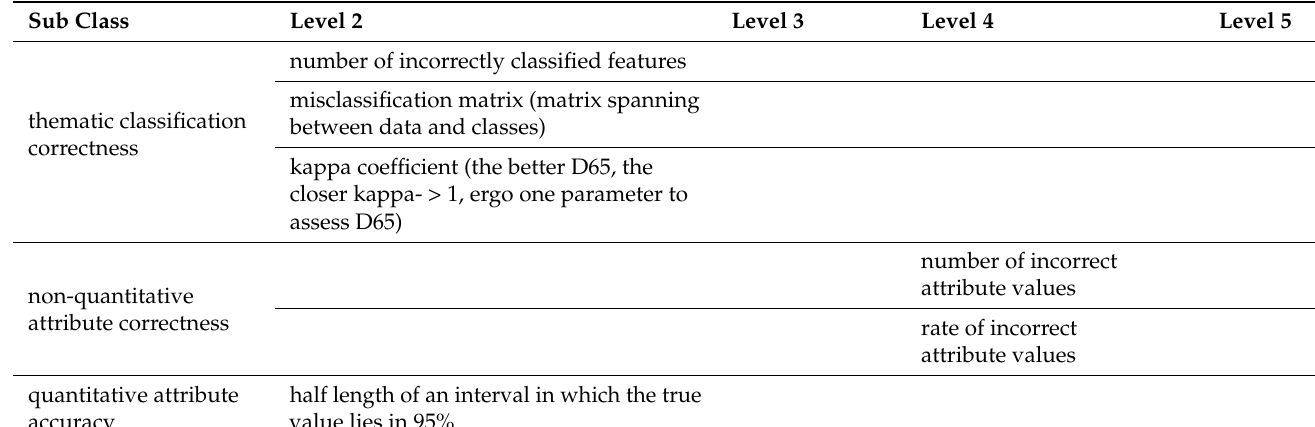
Table A8. Spatial data quality matrix for class thematic accuracy.